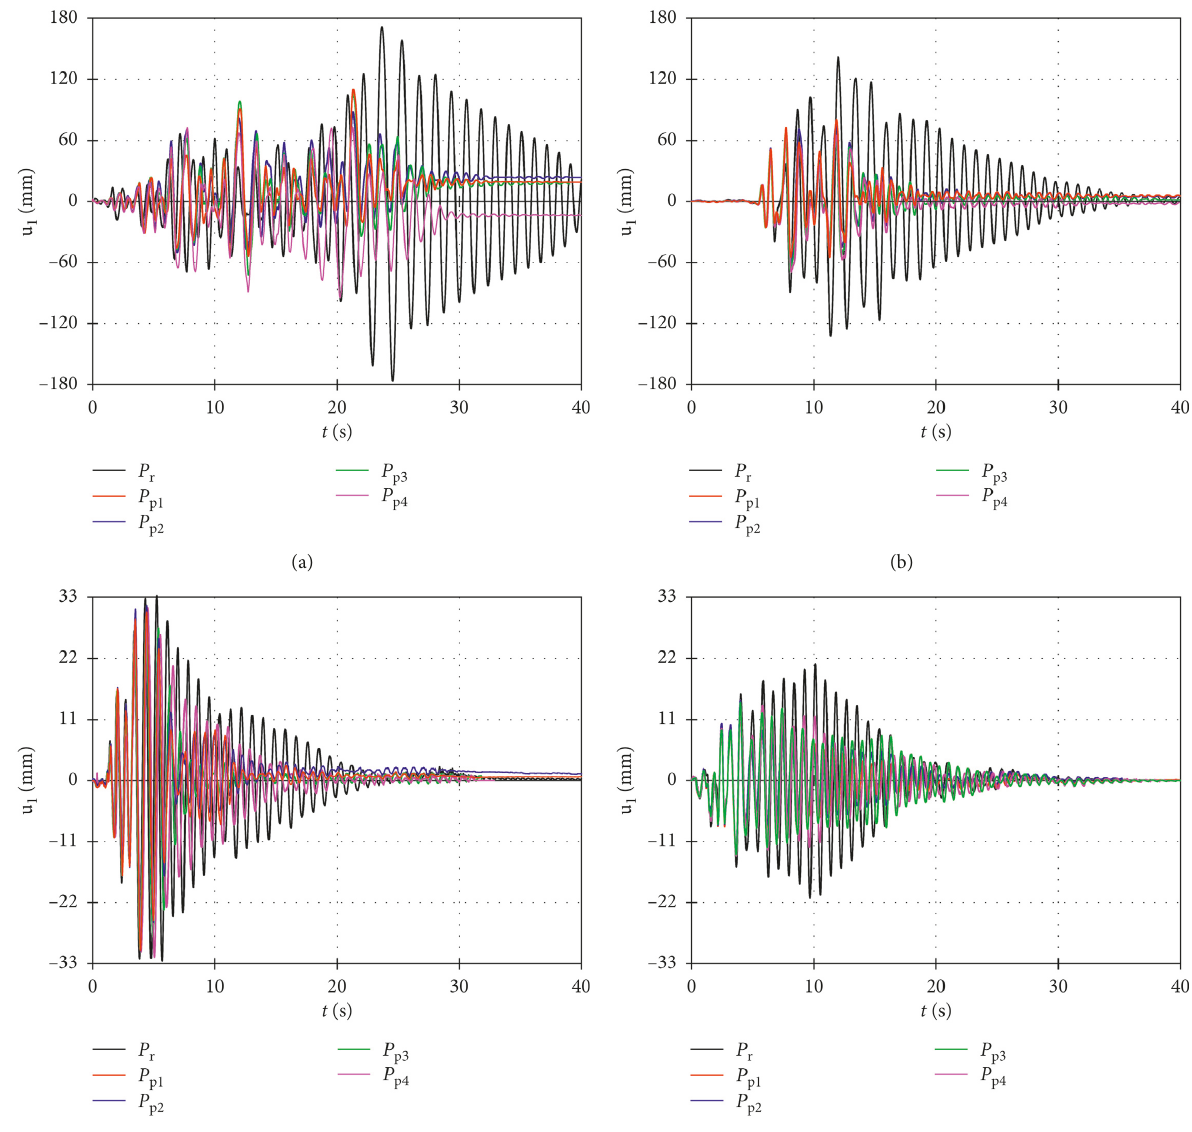
Figure 16: Horizontal displacement of the mass center at the column top ( u Petrovac (AP). (c) Accelerogram Ston (AS). (d) Accelerogram B. Luka